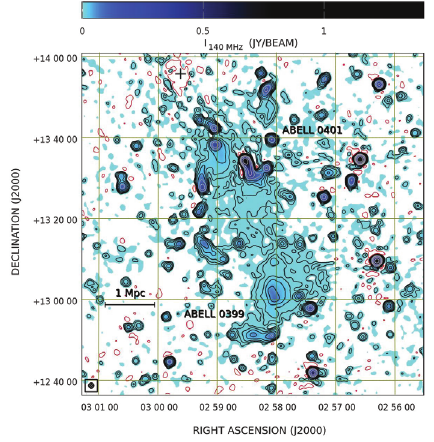
Figure 17. Ridge of radio synchrotron emission in a filament of the cosmic web, between the merging galaxy clusters A399 and A401. Color and contours show the total intensity of the 140MHz radio continuum emission measured with LOFAR